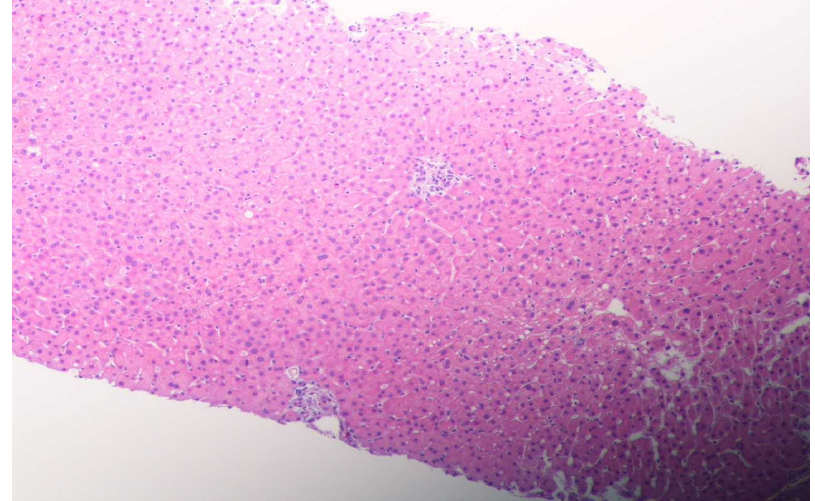
Figure 1. Lobular hepatitis with infiltration by lymphohistiocytic cells and eosinophilic cells, ceroid containing macrophages and mild hepatocellular swelling consistent with drug-induced liver injury. (H&E, magnification ×100, low power.)